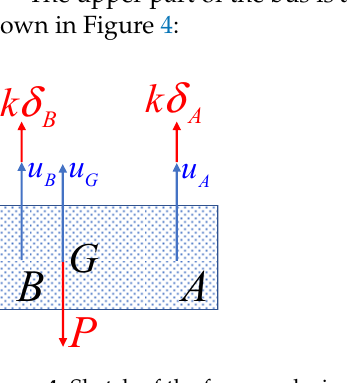
Figure 4. Sketch of the force analysis of the upper part of the bus.